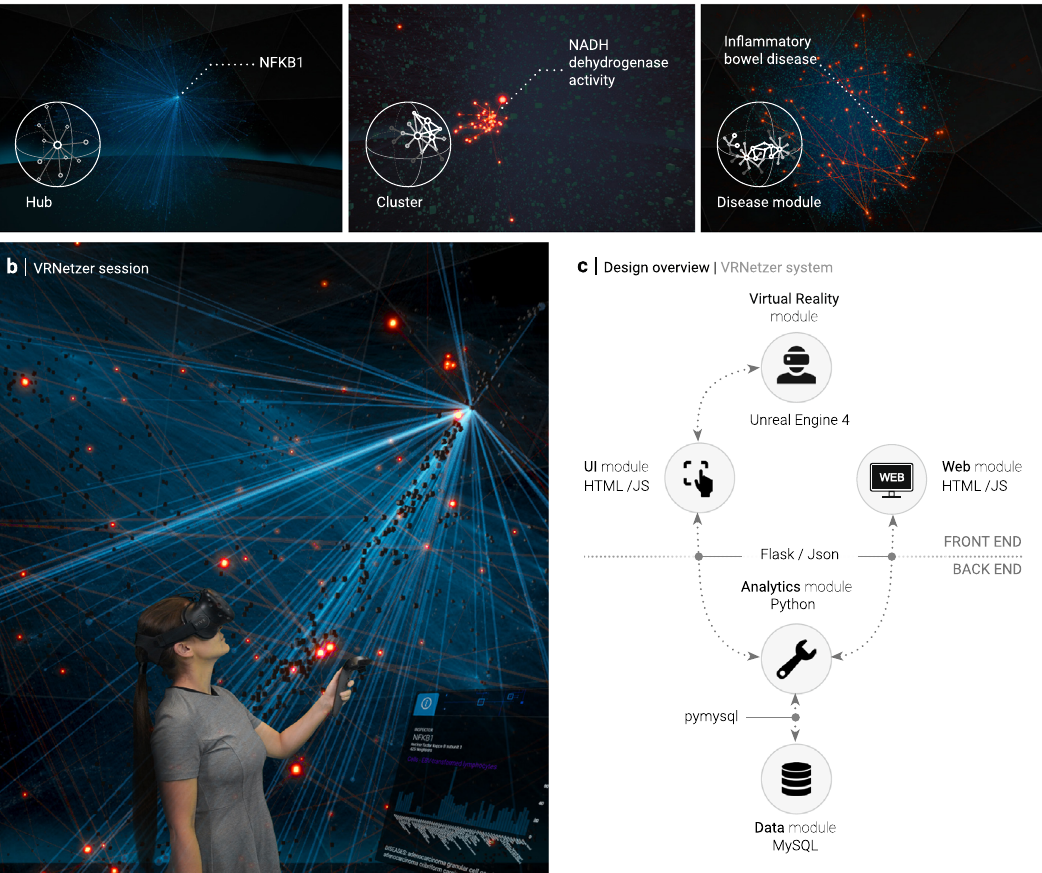
Fig. 1 A Virtual Reality (VR) network exploration platform. a Three examples of visual network patterns with direct biological interpretations. Left: highly connected hub, indicating essential and often pleiotropic gene functions. The depicted NFKB1 gene is a subunit of an essential transcription factor involved in a wide variety of biological processes. Middle: small, densely interconnected clusters often represent a particular biological function. The highlighted cluster corresponds to the NADH-dehydrogenase, the fi rst complex of the electron transport chain. Right: genes associated with the same disease are often characterized by larger, yet signi fi cantly connected modules, as shown for genes associated with in fl ammatory bowel disease. b Green-screen composition of a user wearing a VR headset and the respective VR scene she is currently exploring. c The VRNetzer platform consists of fi ve modules that can be customized independently. The frontend consists of the VR interface and an additional web browser-based interface to facilitate seamless exchange between VR sessions and standard working environments. The user interface module connects the VR module to the backend, which consists of two separate modules for data storage and data analytics. The individual modules are implemented in programming languages that are widely used for the respective